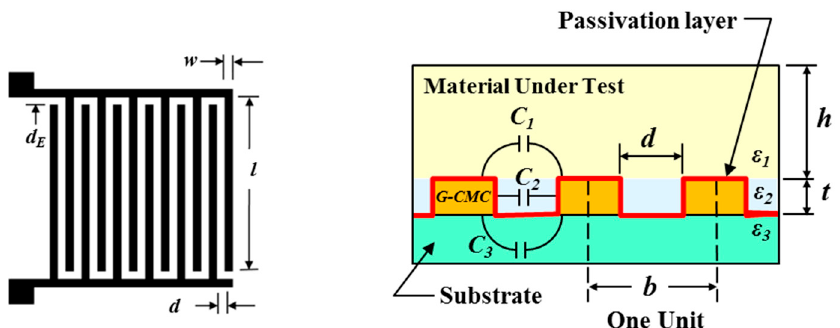
Figure 3. Basic layout design and cross-sectional view of a planar graphene-carboxymethyl cellulose (G-CMC) interdigitated capacitor (IDC) that responds to dielectric changes in the material under test (MUT).